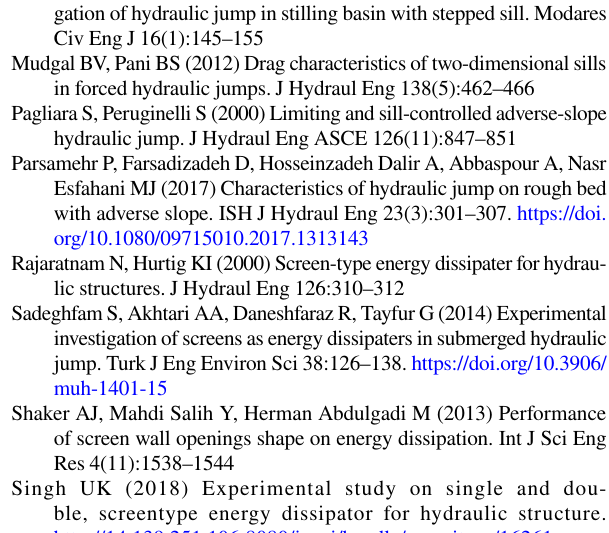
Fig. 10 The comparison of sequent depth ratio y trolled jump on adverse slope with the classic hydraulic